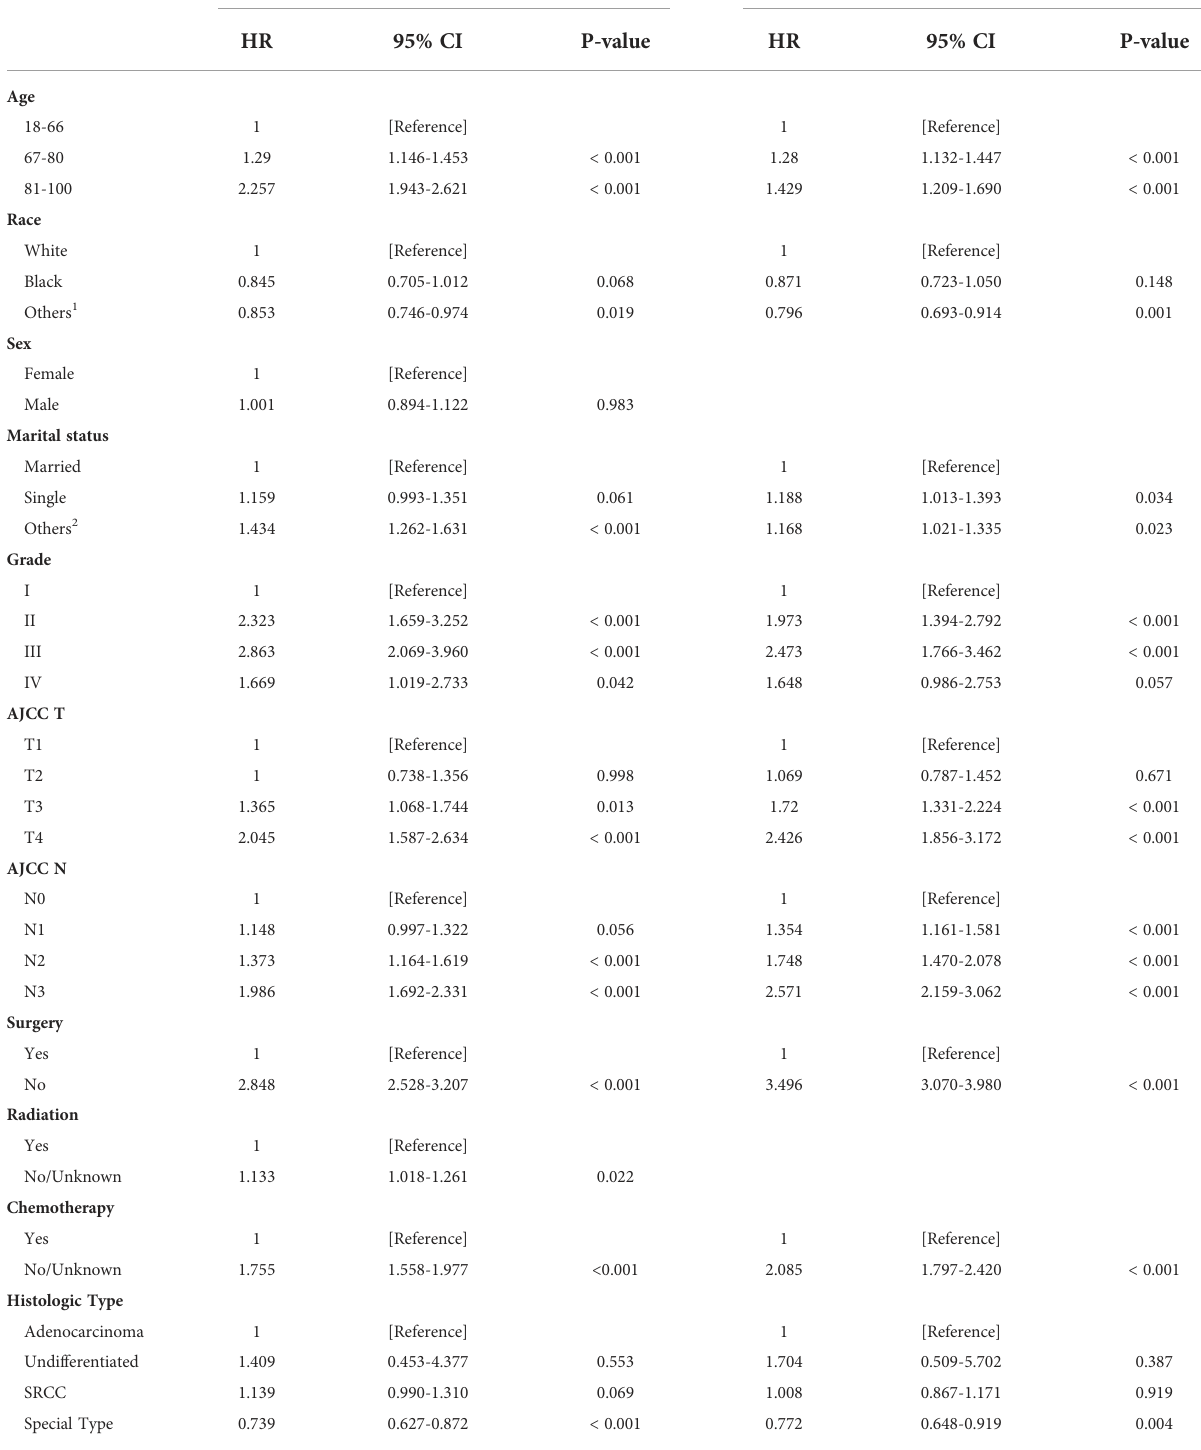
TABLE 2 Overall Survival Univariate analysis and Multivariate analysis of the training